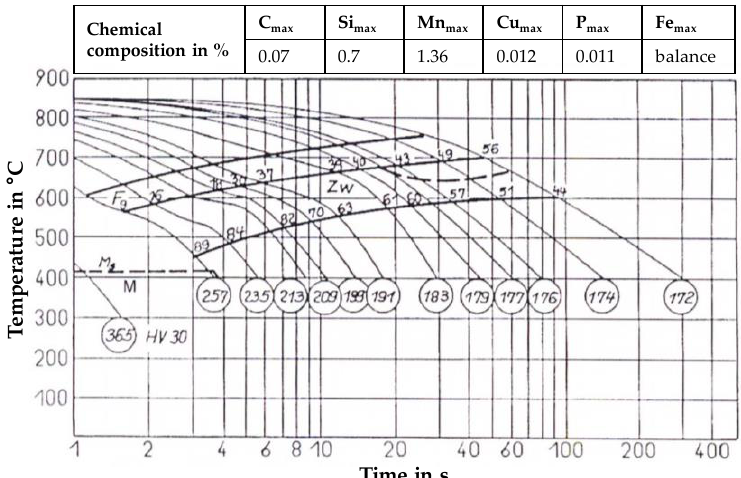
Figure 12. CCT-diagram of low-alloyed steel SG36 with comparable chemical composition to the used welding wire G4Si1/SG3 (1.5130) [37].